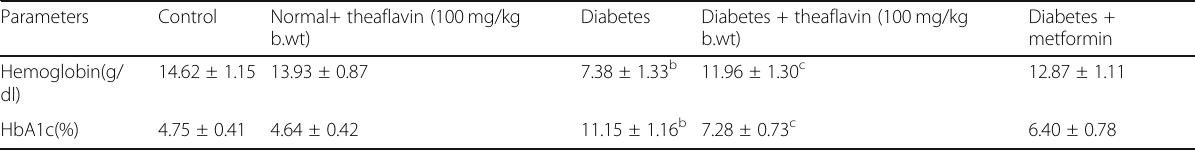
Table 2 Effects of theaflavin on hemoglobin and glycosylated hemoglobin levels in control and experimental animals